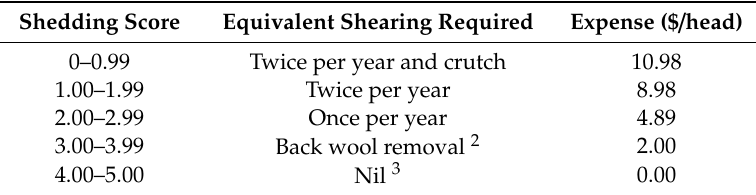
Table 3. Expenses for shearing of sheep with various shedding scores [7] based on 2017 / 18 New Zealand shearing contract rates reported by [41]. Romney shearing expenses consisted of per head expenses of $4.89 for a full summer shear, $4.09 for a second winter shear (with twice yearly shearing policies), and $2.00 for a full crutch 1